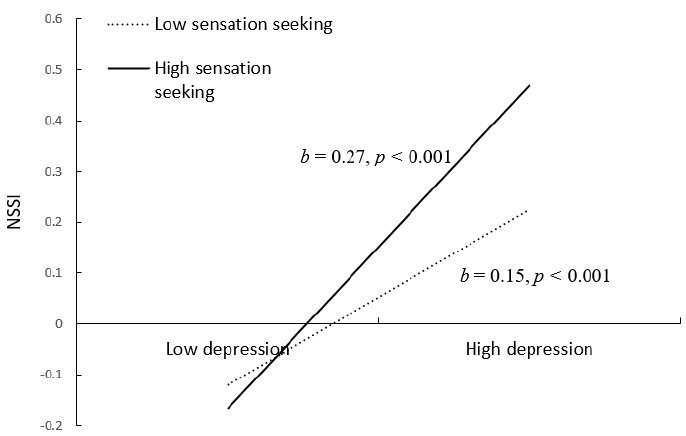
Figure 4. Interactive effect of depression and sensation seeking on NSSI. Note: Sensation seeking is graphed for two levels: high sensation seeking (1 SD above the mean) and low sensation seeking (1 SD below the mean). NSSI = nonsuicidal self − injury. NSSI = non-suicidal self − injury.